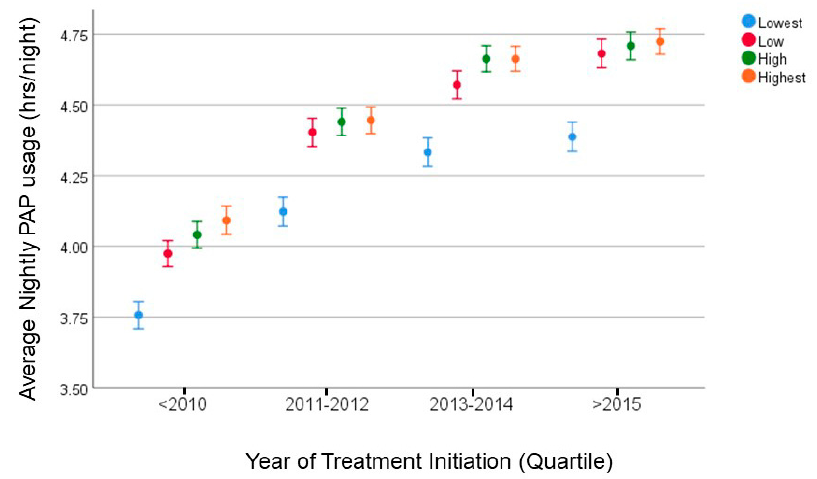
Figure 4. Raw unadjusted adherence to positive airway pressure (PAP) device (with 95% confidence intervals) is shown for various income quartiles as a function of year of set-up or initiation of the PAP device. Notice that there is a clear trend for improvement in adherence as a function of time, but disappointingly the health inequities remain even after 2014 when the Affordable Care Act and Medicaid expansion occurred.